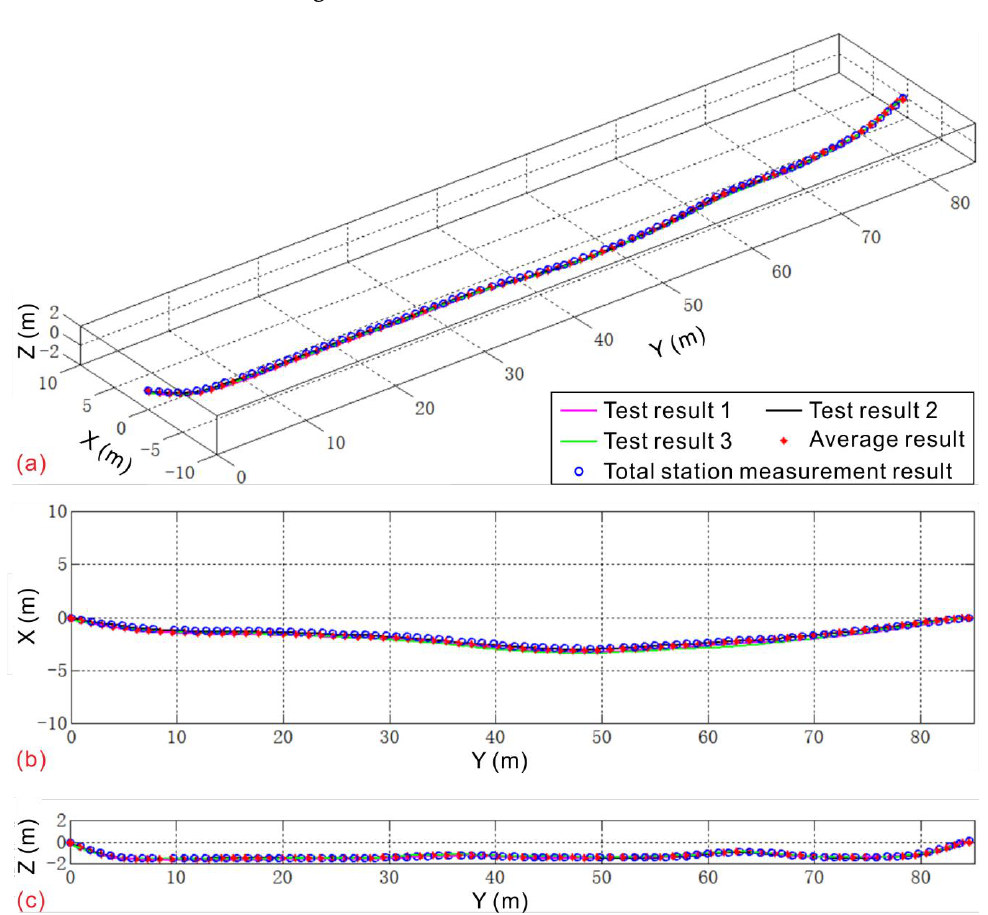
Figure 10. Calibration test results: ( a ) Axonometric view; ( b ) X – Y plane view; ( c ) Y–Z plane view.